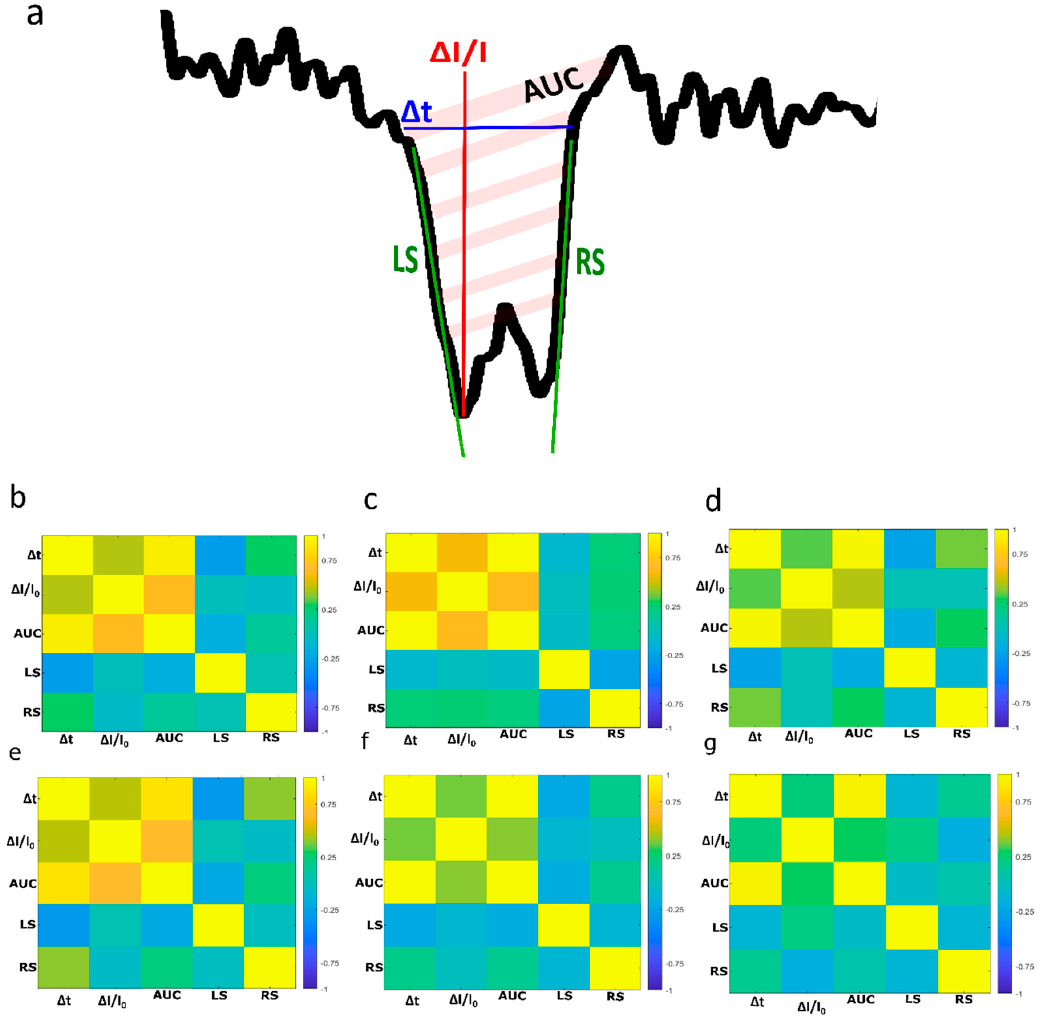
Figure 4. ( a ) Zoom of a translocation event and the representation of variables characterizing events. ( b – g ) Heat map representing the correlation between the variables characterizing events obtained under 250 mV for ( b ) A 10 / T 10 , ( c ) A 40 / T 40 , ( d ) T 40 and at 500 mV for ( e ) A 10 / T 10 , ( f ) A 40 / T 40 , ( g ) T 40 . The results were obtained using the pore d t = 3 nm, d b = 200 nm.